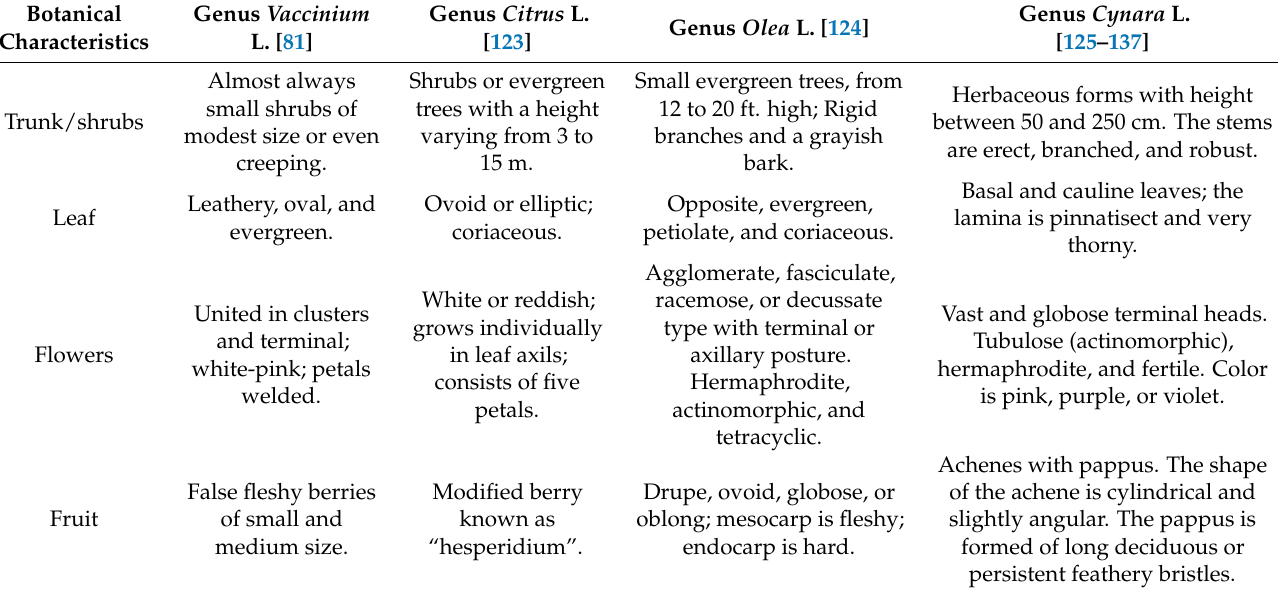
Table 1. Botanical features of genera Vaccinium L., Citrus L., Olea L., and Cynara